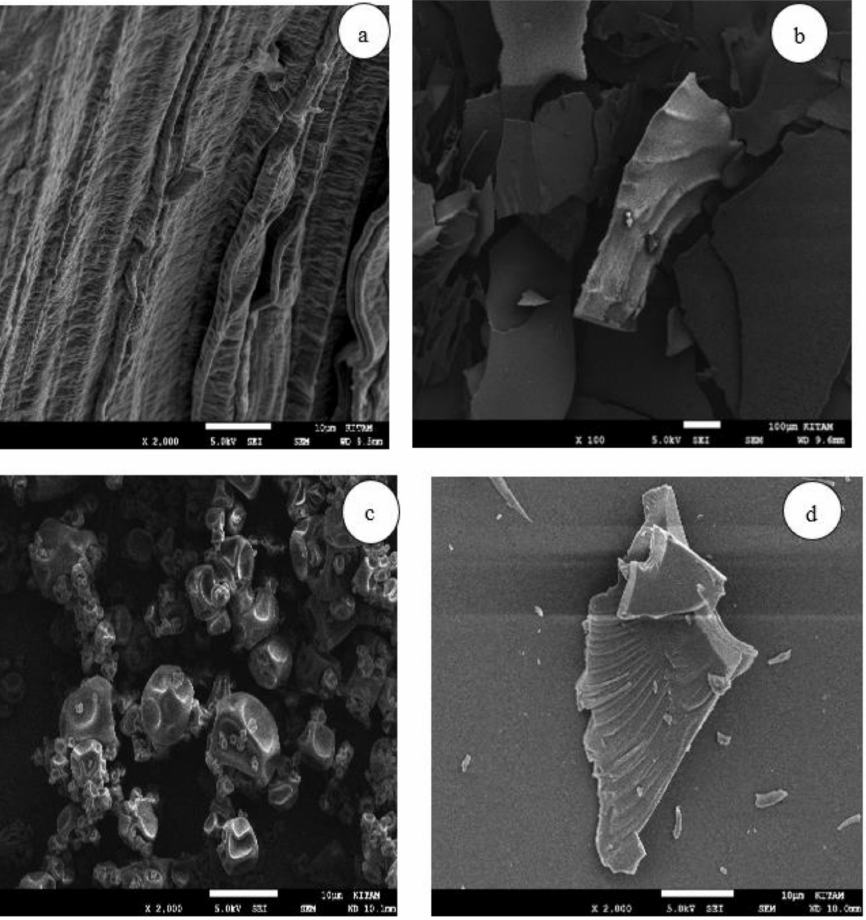
Figure 6. Microstructures of waste extract ( a ), freeze-dried ( b ), spray-dried ( c ), and microwave-dried ( d ) samples.